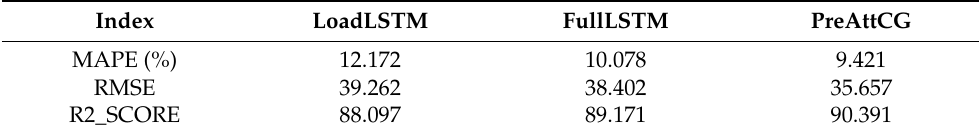
Table 5. Comparison of prediction accuracy indexes (Chinese dataset).